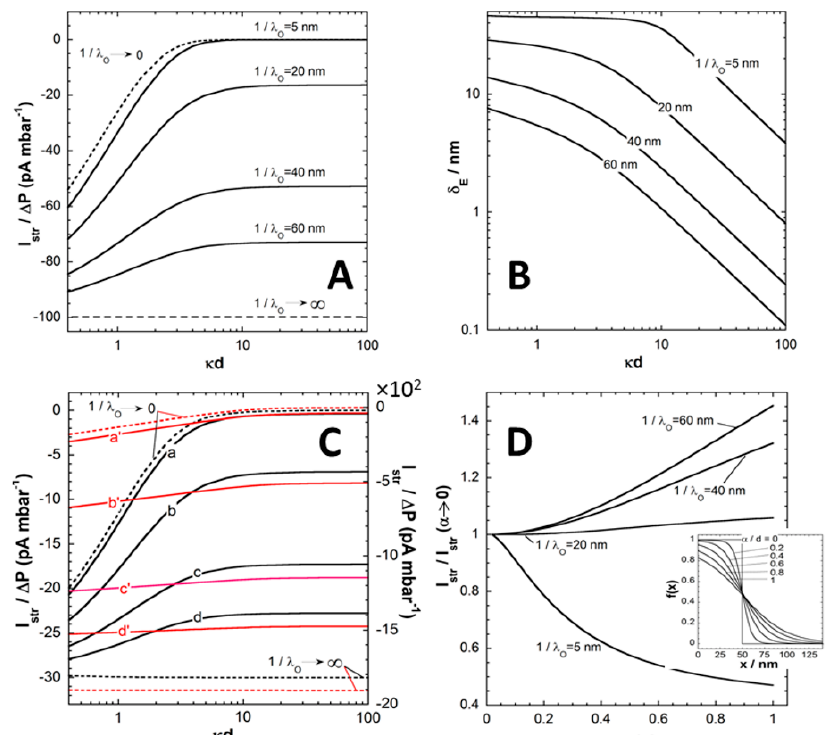
Figure 2. ( A ) Ratio between streaming current ( I str ) and applied pressure ( ∆ P ) versus ionic strength evaluated from theory for different values of the hydrodynamic penetration length 1 { λ O (indicated). ( B ) Electrokinetic layer thickness δ E estimated from theory under the conditions of panel A at various 1 { λ O (indicated). Model parameters in ( A ) and ( B ): ζ “ ´ 90 mV, z “ 1 (monovalent electrolyte), O T = 22 ˝ C, d “ 50 nm, H “ 30 µ m, (cid:96) “ 10 mm, L O “ 20 mm, ε r “ 79.5, η “ 0.954 mPa s ´ 1 , α Ñ 0 (homogeneous segment density distribution in the film), ρ O “ 0 (uncharged film). ( C ) I str { ∆ P versus ionic strength evaluated from theory for | ρ O { F | “ 0.1 mM (black lines, left y -axis) and | ρ O { F | “ 10 mM (red lines, right y -axis) at (a, a’) 1 { λ O “ 5 nm, (b, b’) 1 { λ O “ 20 nm, (c, c’) 1 { λ O “ 40 nm and (d, d’) 1 { λ O “ 60 nm. The limits 1 { λ O Ñ 0 and 1 { λ O Ñ 8 are explicitly indicated. Other model parameters: as in ( A )-( B ) except ζ “ ´ 10 mV ( D ) Ratio I str { I str p α Ñ 0 q as a function of α { d at various 1 { λ O (indicated). Other model parameters: as in ( A ) and ( B ) except that ζ “ ´ 10 mV, | ρ O { F | “ 10 mM and solution ionic strength = 1 mM. In the inset of panel ( D ), representation of the segment density distribution f ( x ) for various values of α { d (indicated) and d “ 50 nm. Adapted from [24]. Copyright 2009 with permission from American Chemical